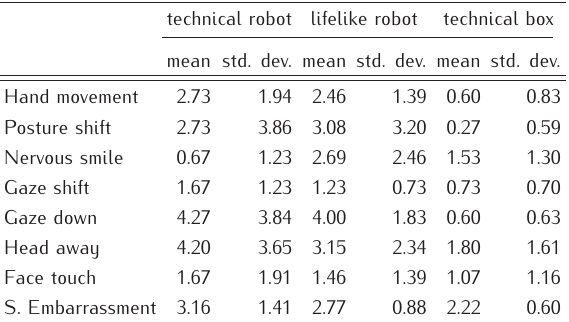
Table 5. Mean and standard deviation for all measurements across all experi- mental conditions.